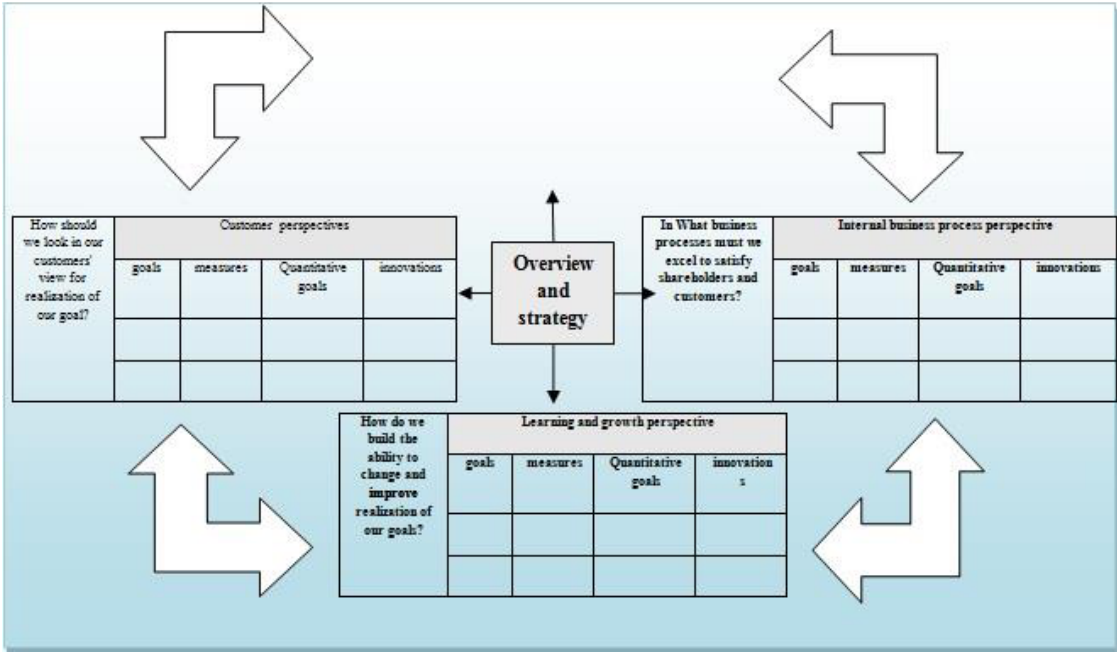
Figure 1. Balanced Scorecard (WLAN-1996)-Kaplan and